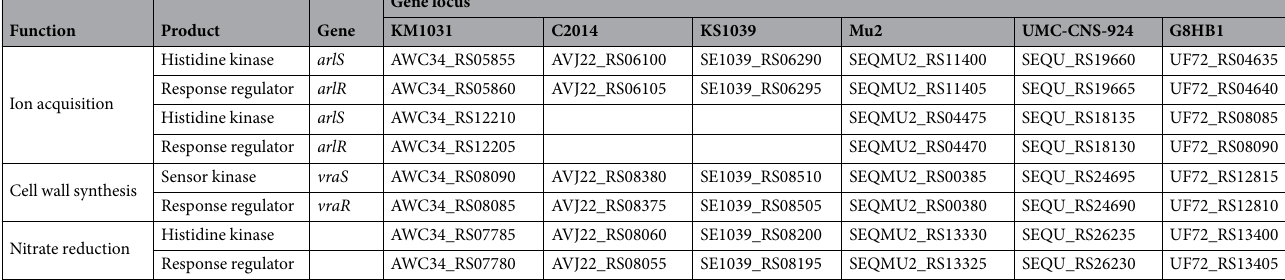
Table 3. Putative two-component systems identified in six S . equorum